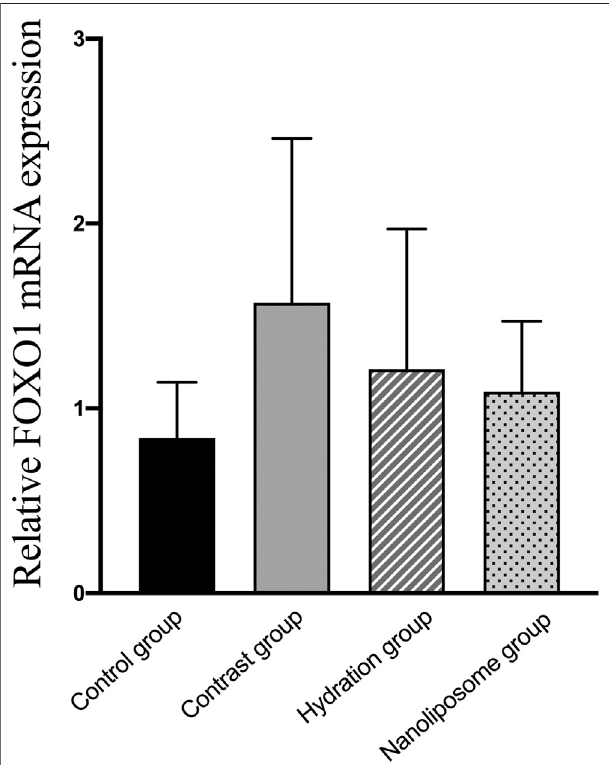
FIGURE12| TherelativemRNAexpressionoftargetgenewasdetected by Real-time PCR. Real-time PCR was used to validate the change in the expression of the FOXO1 gene identi fi ed in four groups. FOXO1 (cid:2) Forkhead box O1. Values are expressed as mean ± SD. *Compared with the contrast group, p < 0.05. **Compared with the contrast group, p < 0.01. # Comparedwiththehydrationgroup, p < 0.05. ## Compared withthehydration group, p <